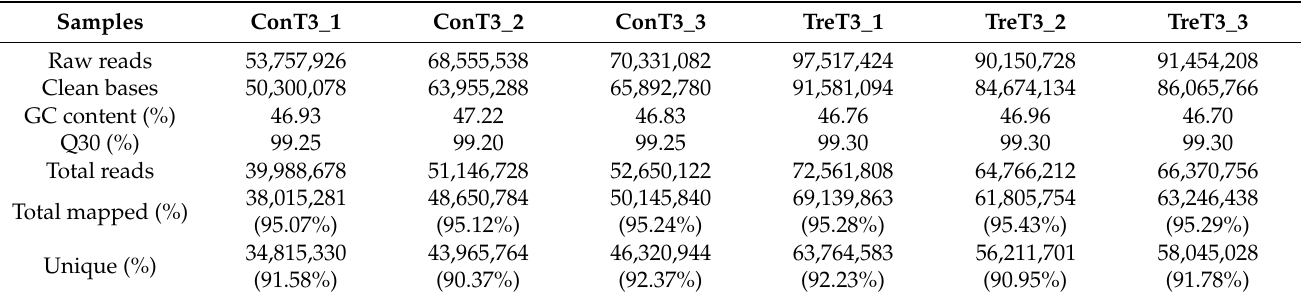
Figure 4. COS affecting on physiological parameters of tea leaves. ( A ) chlorophyll content; ( B ) soluble sugar content; ( C ) SOD activity; and ( D ) POD activity. The data represent the means ± SD of three replicates samples. Different letters indicate significant differences at p < 0.05. Table 1. Statistical analyses and mapping results of RNA sequencing